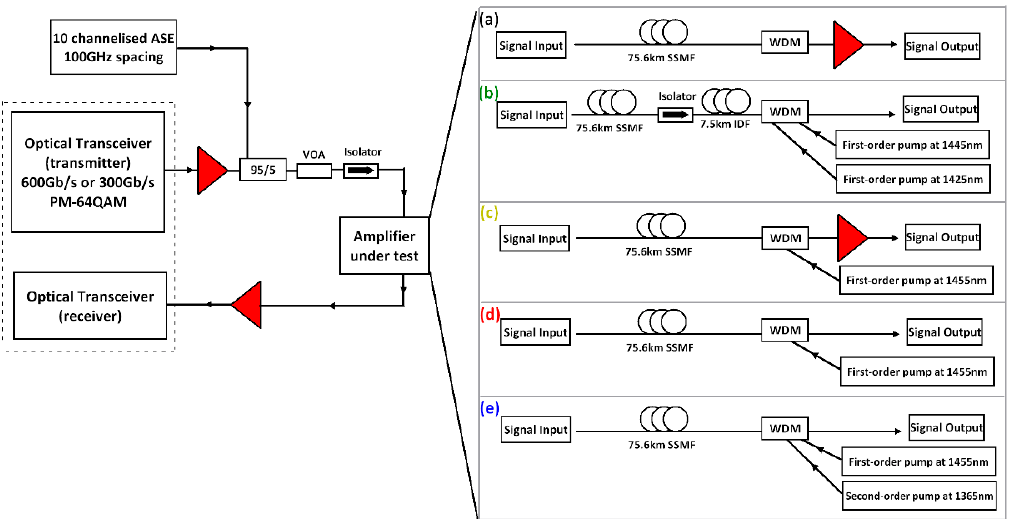
Figure 1. Experimental setup showing high-data-rate transmission with different amplification schemes: ( a ) EDFA only; ( b ) discrete Raman amplifier; ( c ) hybrid Raman/EDFA; ( d ) first-order distributed Raman amplifier; ( e ) second-order distributed Raman amplifier.